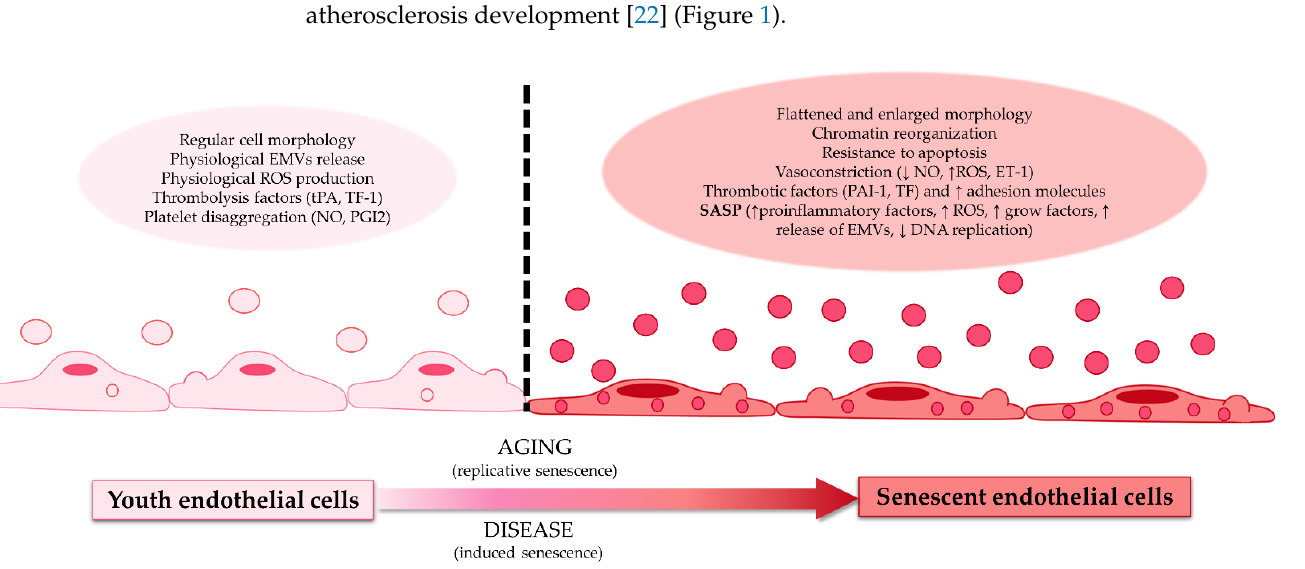
Figure 1. Differences between youth endothelial cells and senescent endothelial cells. Youth endothelial cells presented regular morphology, physiological release, and the production of extracellular microvesicles (EMVs), reactive oxygen species (ROS), a thrombolysis factor (such as tissue factor 1 (TF-1) or tissue plasminogen activator (tPA)), and platelet disaggregation factors (like nitric oxide (NO) or prostaglandin I 2 (PGI2)). These endothelial cells transform with age (replicative senescence) or with disease (induced senescence) into senescent endothelial cells. Senescent endothelial cells have a flattened and enlarged morphology, presenting chromatin reorganization; resistance to apoptosis; vasoconstriction factors (reduction of NO, increase of ROS, and endothelin receptor 1 (ET-1)); thrombotic factors (such as tissue factor (TF) and plasminogen activator inhibitor-1 (PAI-1)); an increase of adhesion molecules; and the senescence-associated secretory phenotype (increase secretion of proinflammatory factors, ROS, growth factors, EMVs, and diminution of DNA